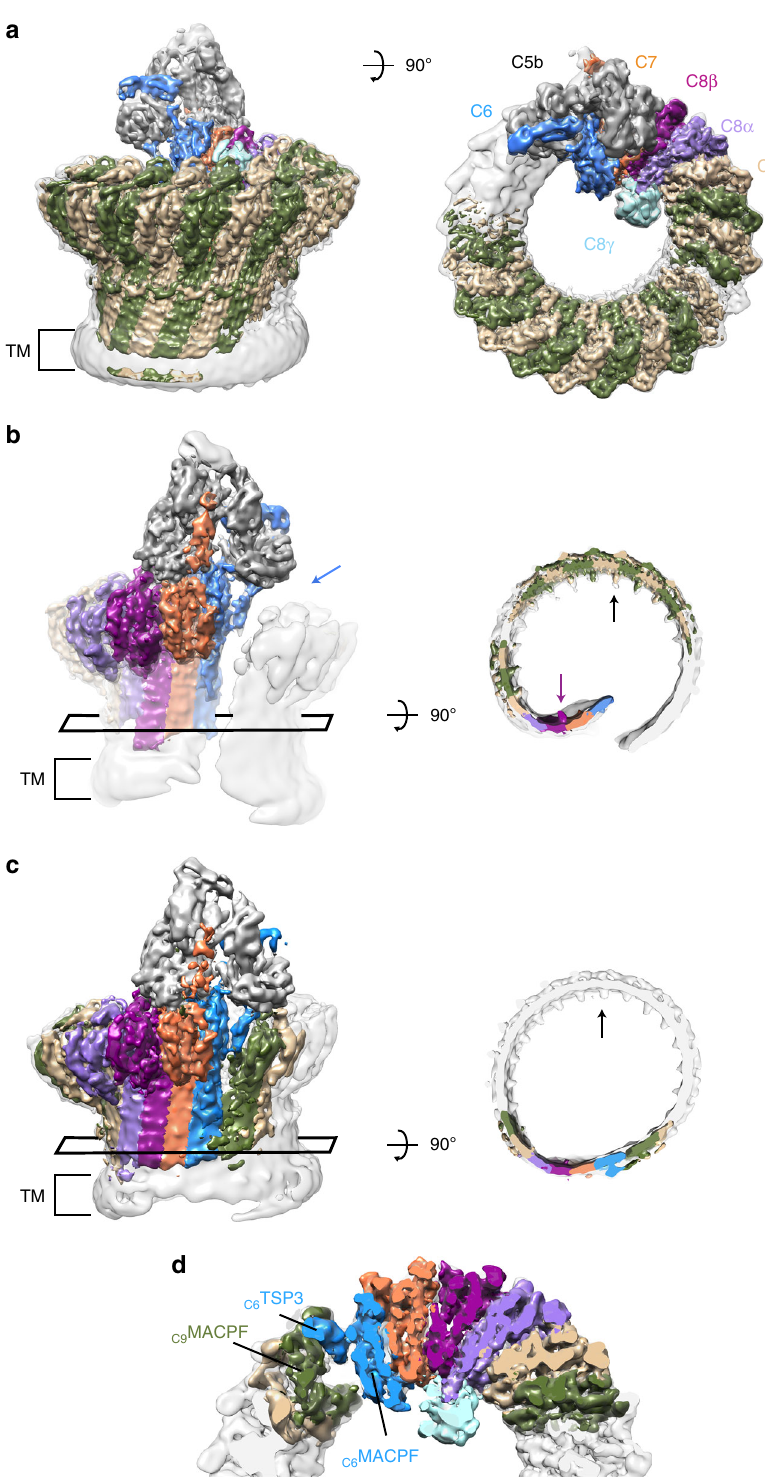
Fig. 1 CryoEM structures of MAC reveal conformational fl exibility of the pore. a CryoEM density map for the open conformation (gray transparent surface) overlaid with subvolume reconstructions of the asymmetric, hinge and C9 oligomer regions (colored according to protein components). Transmembrane region is indicated (TM). b CryoEM reconstructions in a rotated 180°. Blue arrow indicates the gap between C6 and terminal C9 of the split washer. A rectangle highlights a cross-section of the MAC β -barrel shown in the right panel. Black arrow highlights density for C9 glycans that protrude into the lumen of the barrel. Purple arrow indicates density for N-linked glycosylation of C8 β (N189) within the hinge. c CryoEM map of the closed conformation (gray transparent surface) overlaid with the subvolume reconstruction of the asymmetric region (colored density) in the same orientation as b . Rectangle indicates the cross-section shown in the right panel. d Closed conformation of the MAC slabbed through the core MACPF domains. C6 TSP3 and MACPF domains of C6 and C9 are